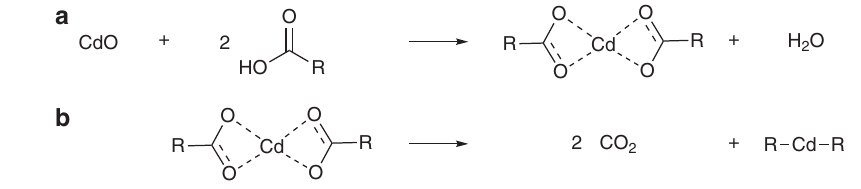
Fig. 4 Cadmium carboxylate reaction schemes. a The formation of cadmium carboxylate. b The thermal decarboxylation as proposed in this